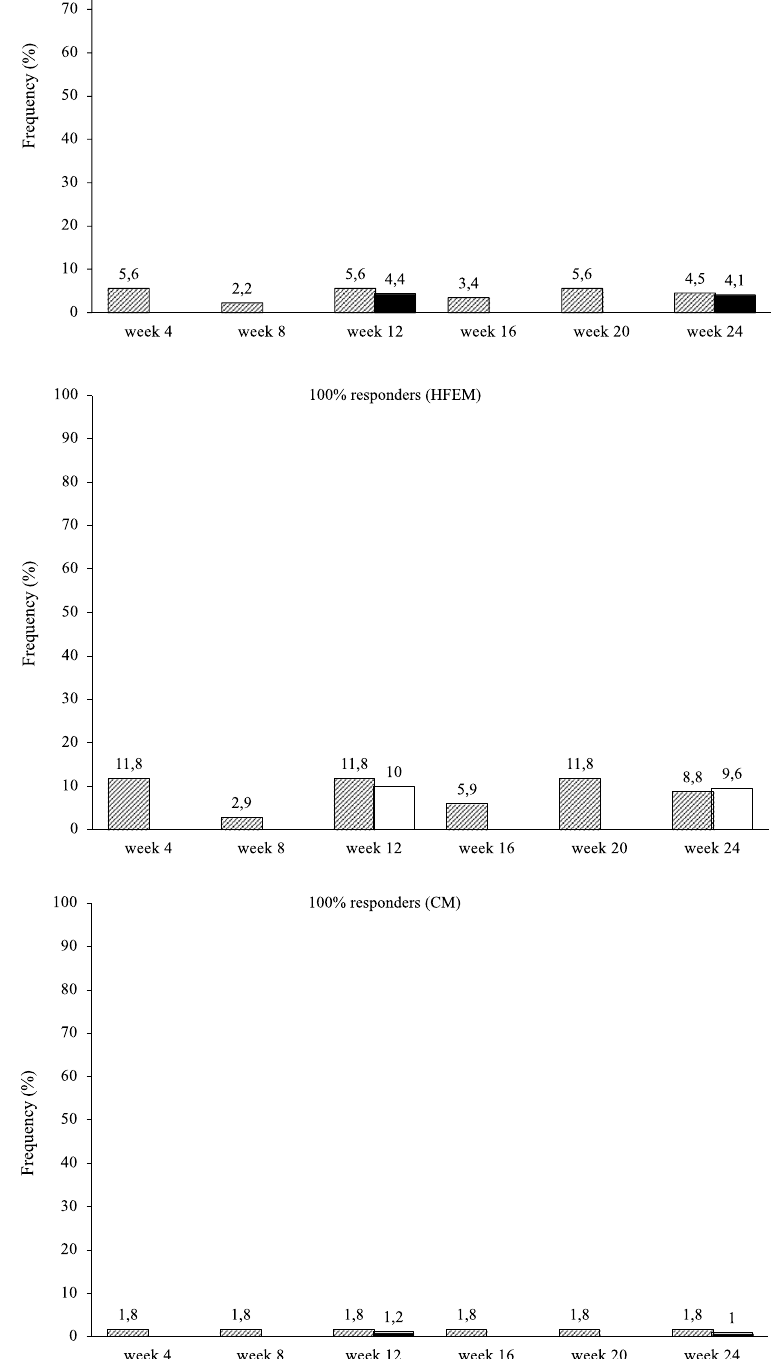
Fig. 5 Proportion of patients with a 100% reduction in monthly migraine/headache days. Black bars: patients from headache centers providing data at weeks 12 and 24 ( n 148). Hatched bars: patients from headache centers providing data at weeks 4, 8, 12, 16, 20 and 24 ( n = high-frequency episodic migraine; CM: chronic